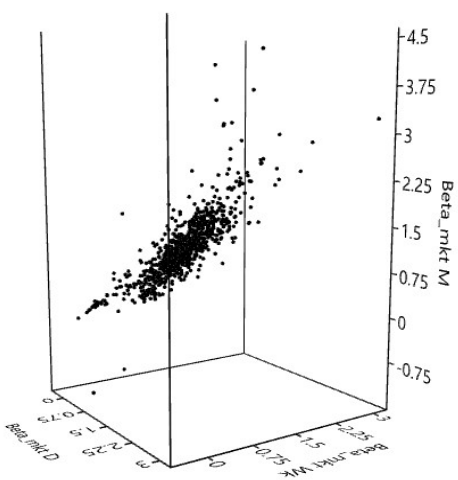
Figure 1. Scatterplot (3-D) of betas derived from daily, weekly and monthly returns (2000–2021).